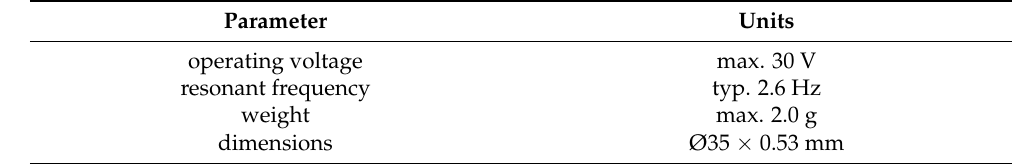
Figure 2. Ceramic piezoelectric transducer CEB-35D26. Table 1. Specifications of Ceramic piezoelectric transducer